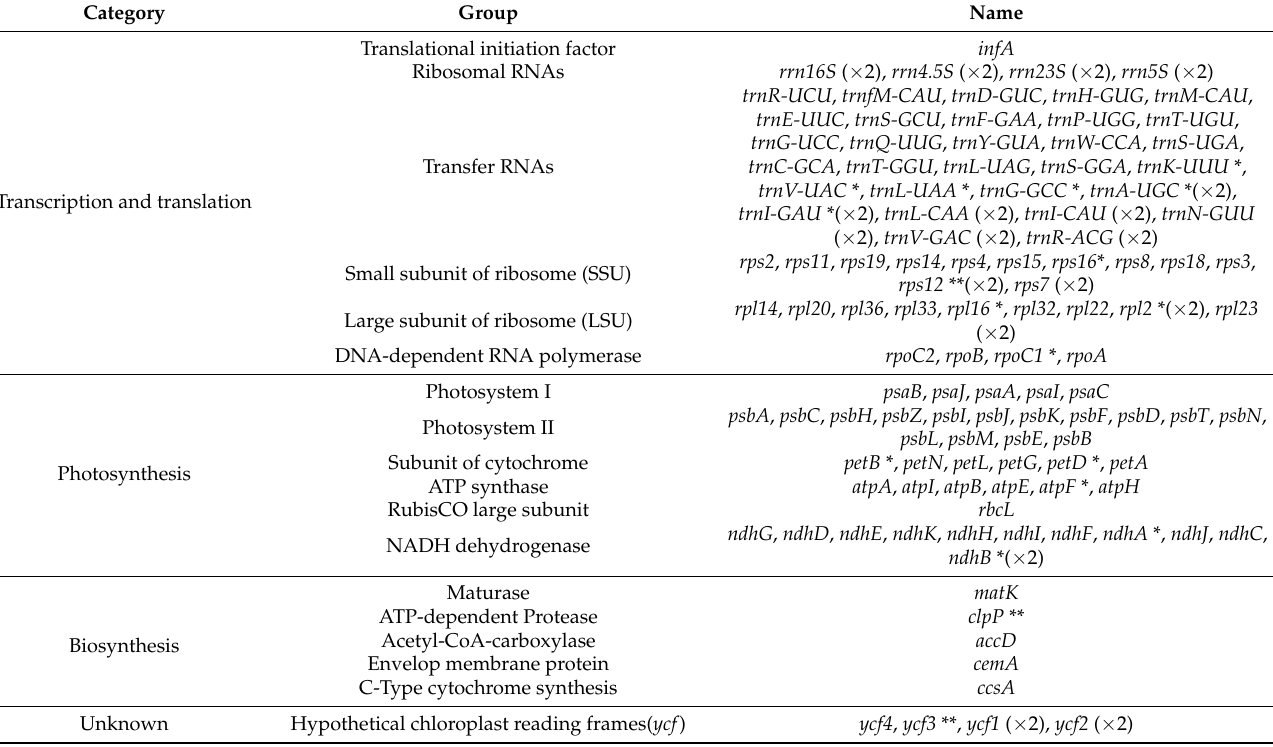
Table 2. Genetic classification of the chloroplast genome of Q. litseoides . Genes marked with the * or ** sign are the gene with single or double introns, respectively. The duplicated genes located in IR regions were marked as ( × 2).